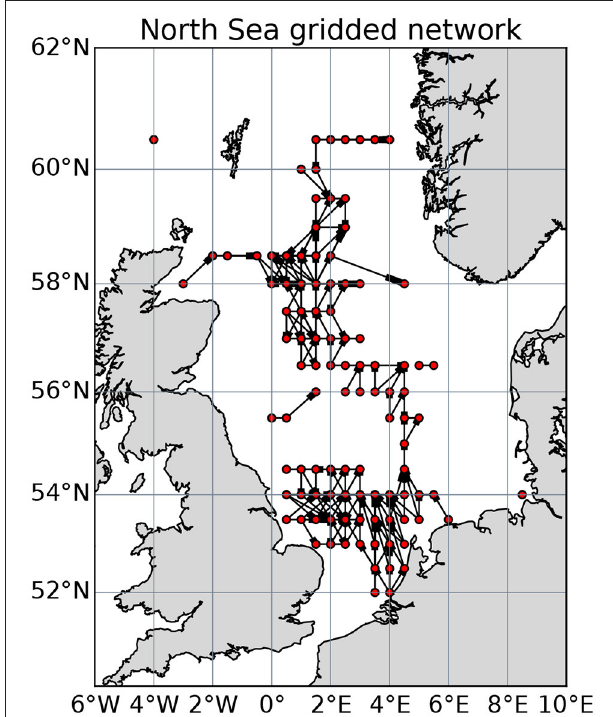
FIGURE 4 | The network of connected North Sea oil and gas installations gridded at 0.5 by 0.5 degrees. Directed connections are thickened in the direction of